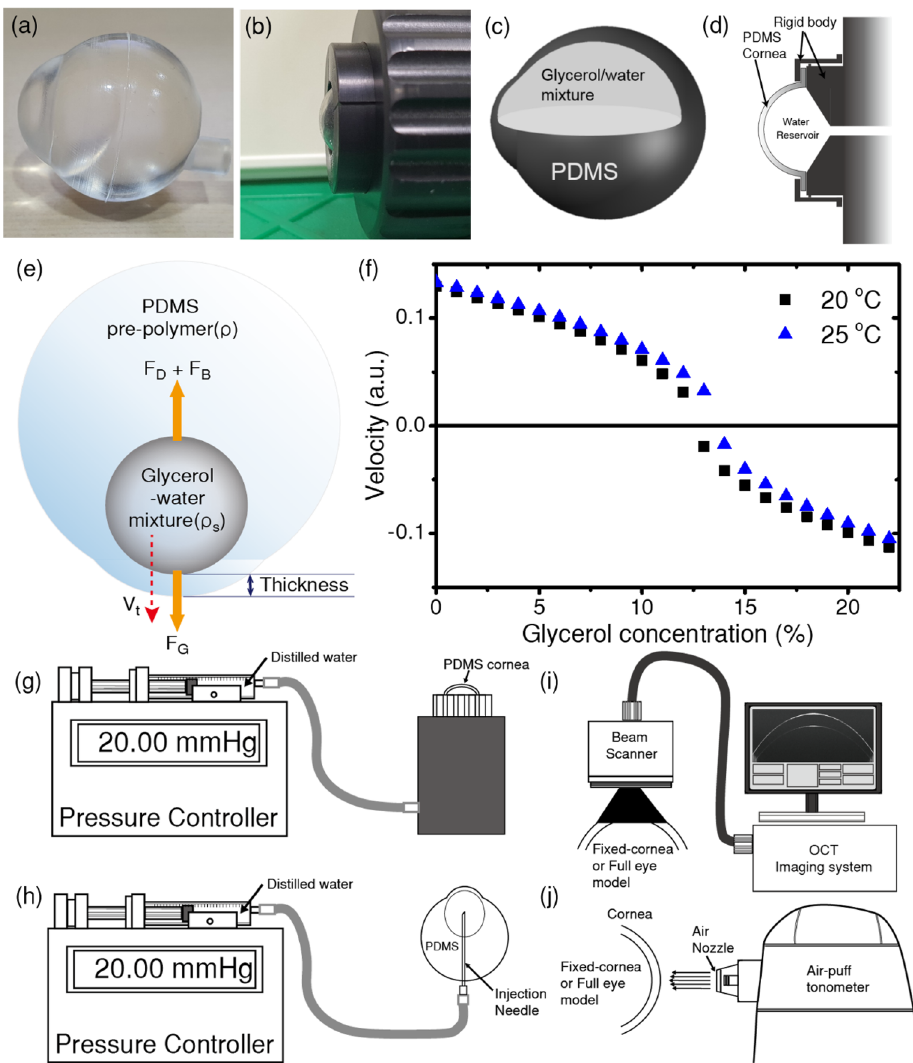
Figure 6. Photographs of the full eyeball phantom ( a ) and cornea eyeball phantom ( b ) and their cross-sectional views of the two eye phantoms are shown in ( c ) and ( d ), respectivel. Diagram of a glycerol-water mixture in polydimethylsiloxane (PDMS) prepolymer ( e ). In this case, the density of the glycerol-water mixture ( ρ s ) is higher than that of PDMS prepolymer ( ρ ). The relationship between the glycerol concentration of the glycerol- water mixture and the velocity of the glycerol-water mixture drop in the PDMS prepolymer when the ambient temperature is 20 °C and 25 °C ( f ). When the glycerol concentration is near 13%, there is a singular time-point at which the drop of glycerol-water mixture changes its direction of movement. Syringe pump-based pressure control system for the cornea eyeball phantom ( g ) and full eyeball phantom ( h ). The schematic diagrams for measuring the structural deformation with optical coherence tomography and non-contact tonometer readings of the cornea are shown in ( i ) and ( j ), respectively.